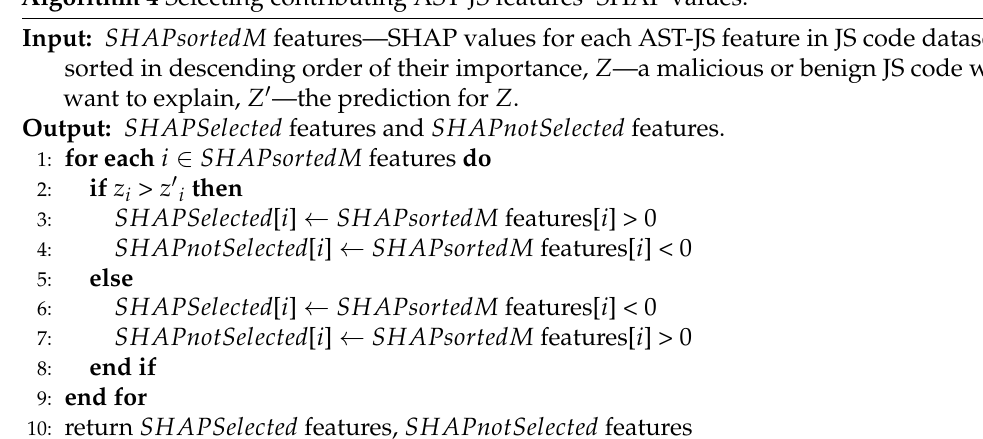
Algorithm 4 Selecting contributing AST-JS features’ SHAP